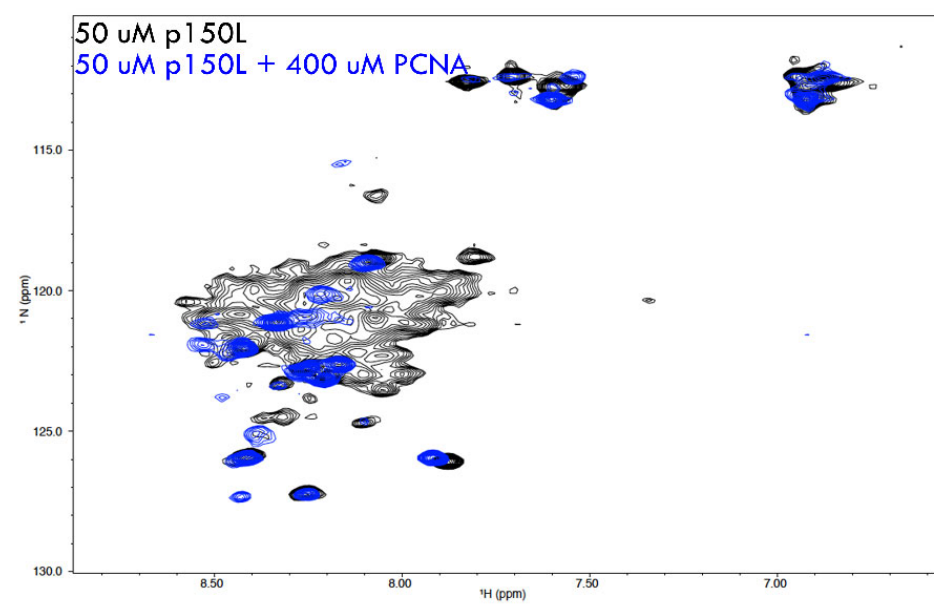
Figure 8. Binding of [15N]-p150L to PCNA studied by nuclear magnetic resonance. Overlay of NMR spectra from 15N-labelled p150L and a complex of p150L with